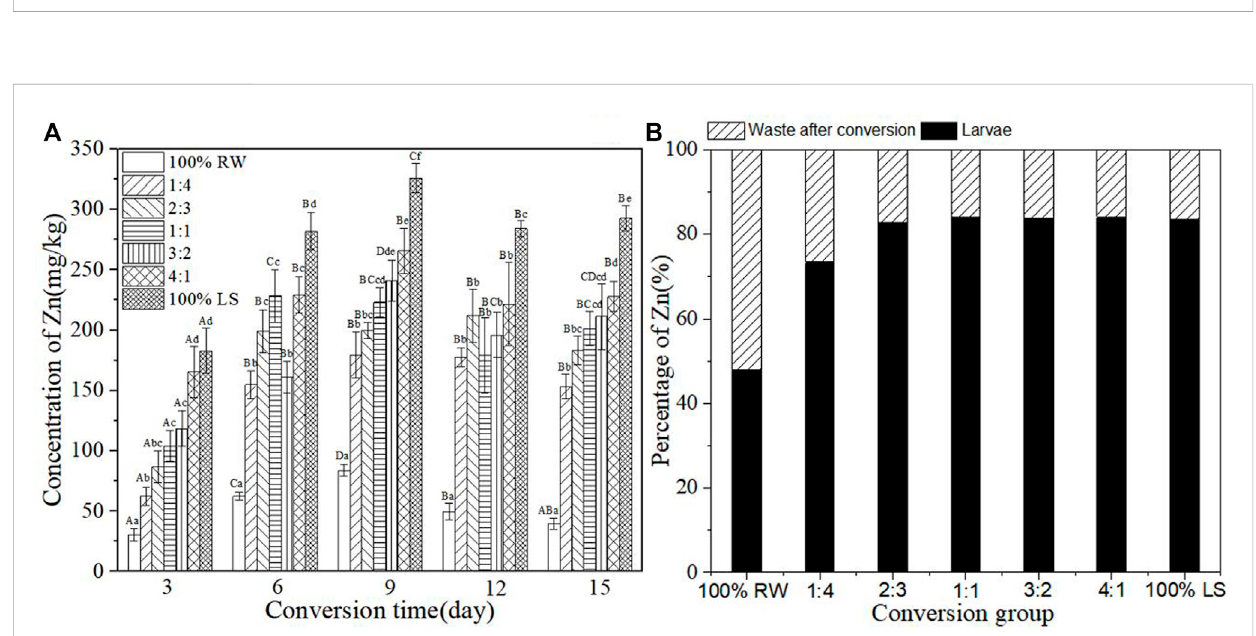
FIGURE 3 (A) -Concentration of heavy metal Cu in BSFL during the conversion; (B) : Percentage of Cu in larvae and waste after conversion. 100% LS:100% lake sediment, 100% RW:100% restaurant waste. The small letters in the Figure 3A indicate the signi fi cance of heavy metal content in BSFL in different groups at the same time. Capital letters indicate the signi fi cance of heavy metal content of the same group at different times (n=3; P > 0.05).